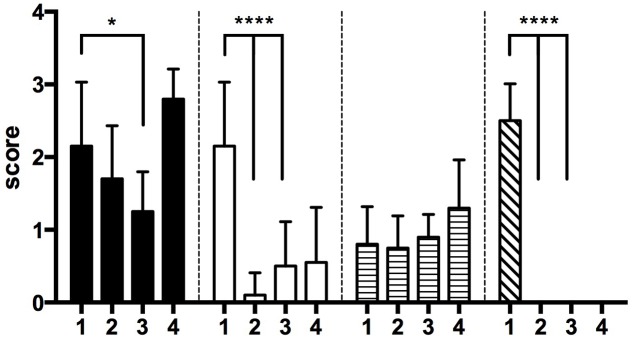
Histological scoring. Tissue sections from excised glands from two mice were processed for histological scoring and read by a veterinary pathologist. Scores (y-axis) represent the average of 10 semi-quantitative evaluations for each gland using the following criteria (see Materials and Methods for detailed explanation): 0 = Absent, 1 = Minimal, 2 = Mild, 3 = Moderate, 4 = Severe. Groups consist of: black bars = Necrosis, white bars = PMN, horizontal striped bars = Lymphocytes, and diagonal striped bars = Bacteria. Conditions are (1) PBS treatment (negative control group), (2) cefalonium treatment (positive control group), or (3) bacteriophage cocktail treatment (phage treatment group), and (4) uninfected mice infused with the phage cocktail (safety control group). Statistically significant differences were observed between PBS treatment (1) and cefalonium (2) or PBS treatment (1) and phage treatment (3) where indicated (∗P < 0.05, ∗∗∗∗P < 0001, Mann–Whitney). Error bars represent standard deviation.